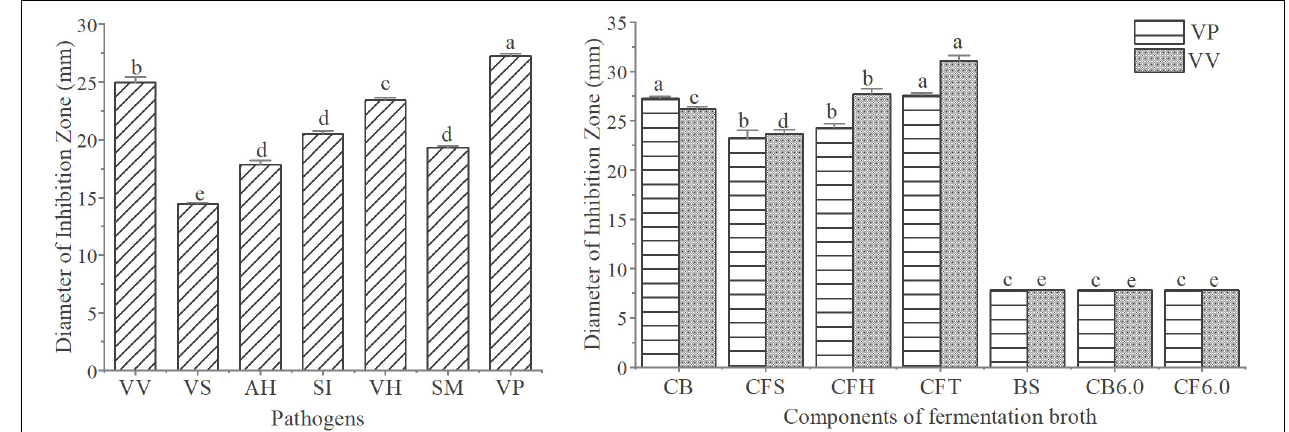
FIGURE 3 | Analysis of the antagonistic activity of W2. (A) Antibacterial activitys of W2 against seven pathogen ( V. vulnificus S01P2, V. splendidus BSD11, V. harveyi SRTT9, V. parahaemolyticus 20130629002S01, Streptococcus iniae NUF849, Aeromonas hydrophila AP40301, Shewanella marisflavi AP629). (B) Antibacterial activitys of different fermentation components of W2 against two Vibrios ( V. parahaemolyticus 20130629002S01, V. vulnificus S01P2). The groups are as follows: culture broth (CB), cell free supernatant (CFS), cell free supernatant with H 2 O 2 removal (CFH), cell free supernatant treated with tripsin (CFT), biomass suspension (BS), cell free supernatant at pH 6.0 (CB6.0), culture broth at pH 6.0 (CF6.0). P < 0.05.